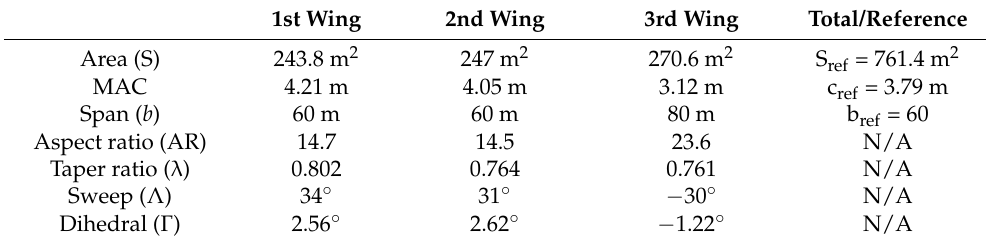
Figure 11. Box-Wing Aircraft/SmartLiner (BWA/SL) concept. ( Left ): Early drawing of the BWA/SL with powerplant and one wing folded. ( Right ): CAD model of the clean (unpowered) configuration. Table 4. BWA/SL aircraft: Main characteristics of the planform.